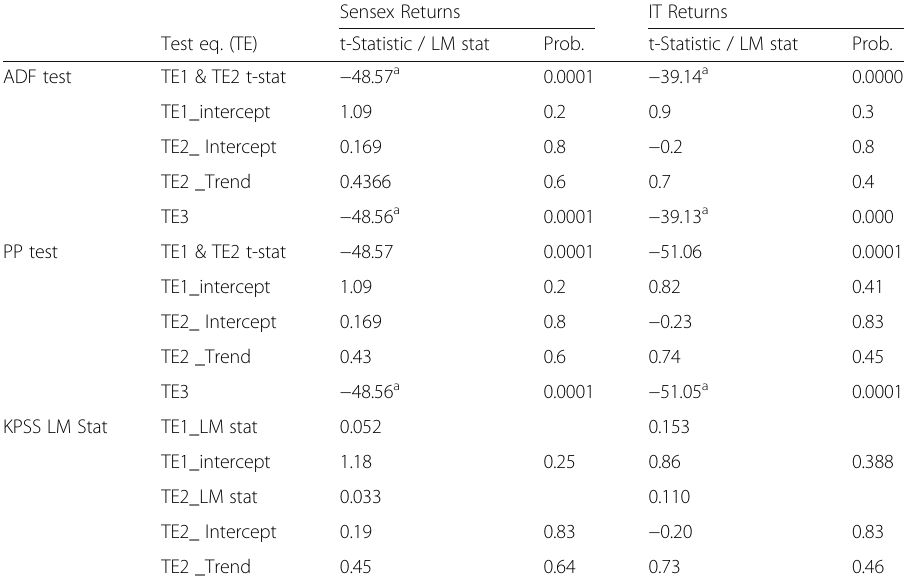
Table 3 ADF test results for S&P BSE Sensex and S&P BSE IT logarithmic returns Sensex Returns IT Returns Test eq. (TE) t-Statistic / LM stat Prob. Prob. ADF test